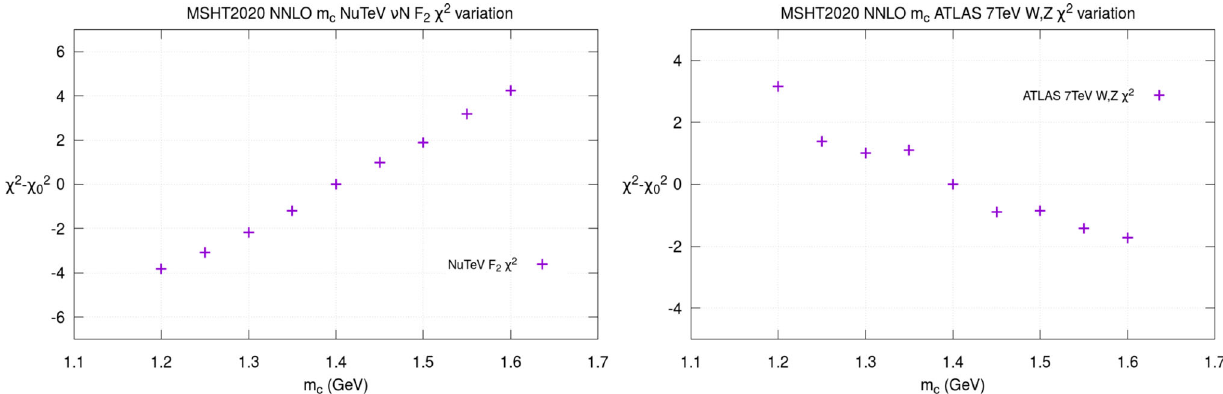
) = 0 . 118 for (left) the NuTeV F Z